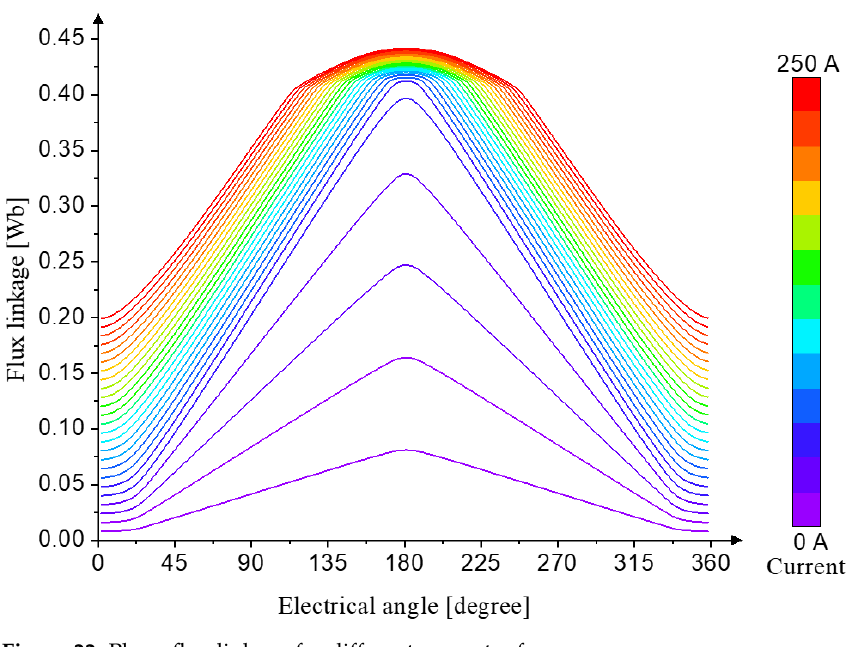
Figure 22. Phase flux linkage for different current references.